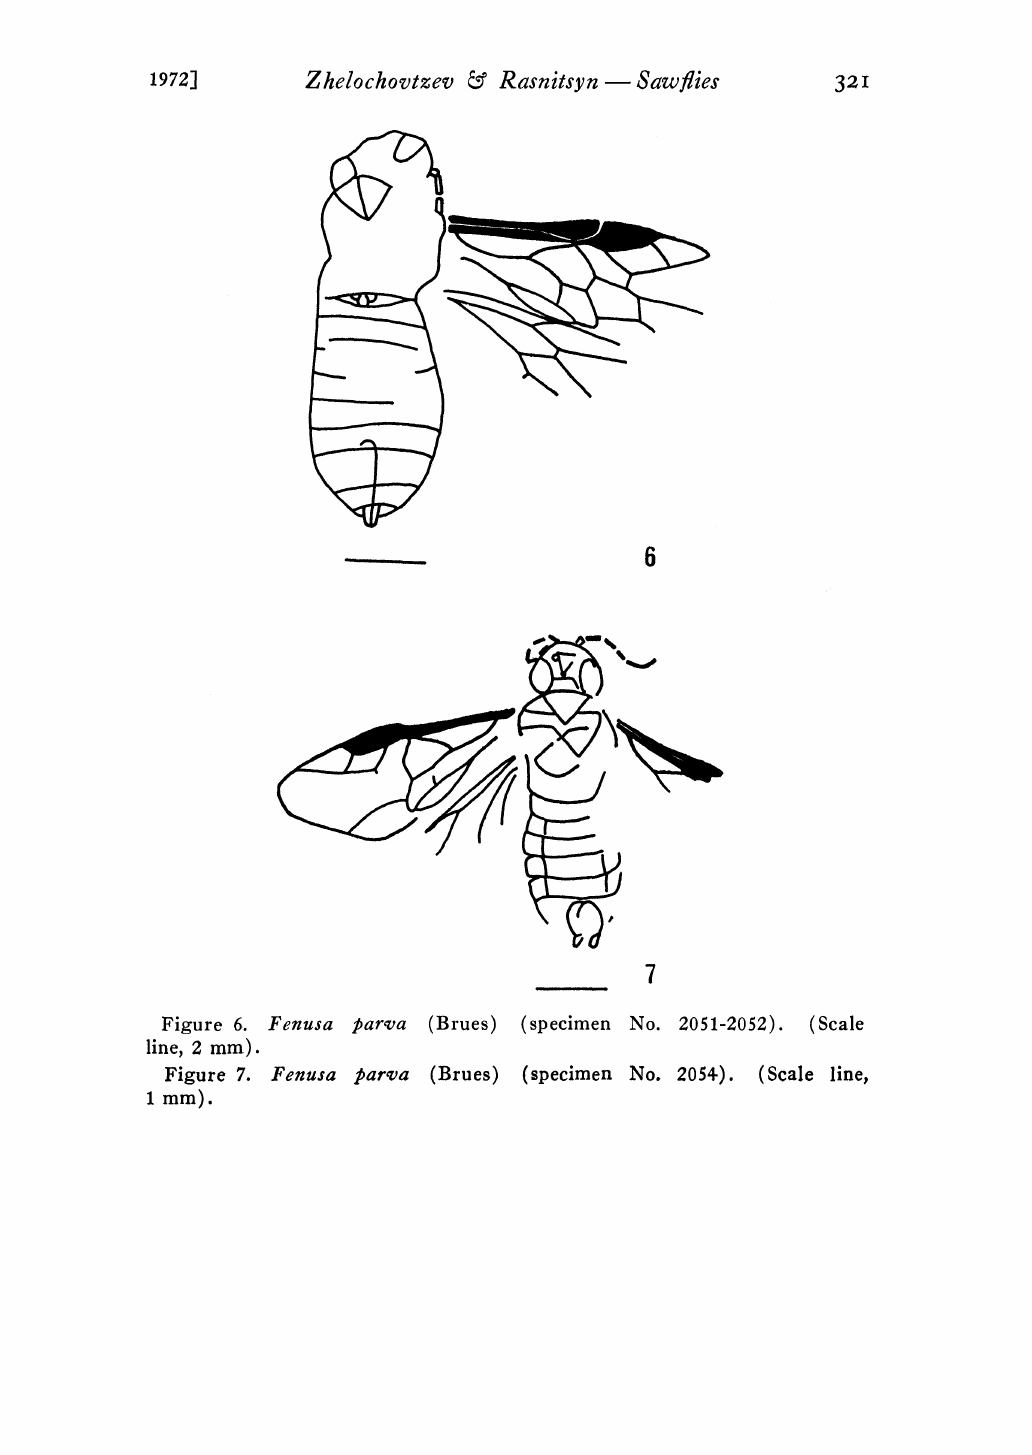
Figure 6. Fenusa par, a (Brues) (specimen No. 2051-2052). (Scale line, 2 mm). Figure 7. Fenusa parca (Brues) (-pecimen No. 2054-). (Scale line,